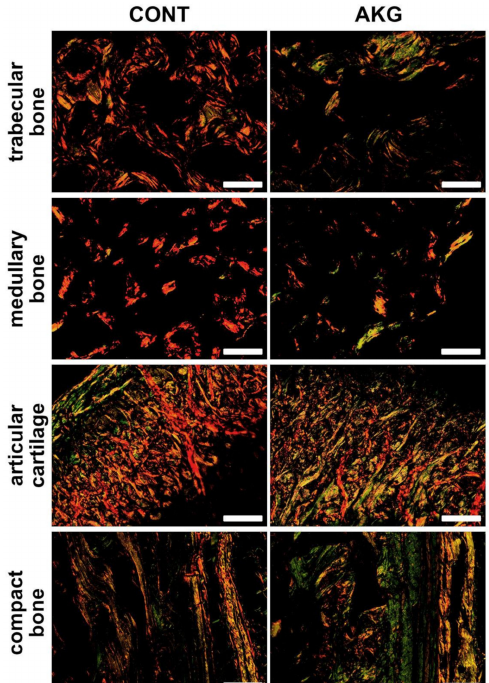
Figure 4. The influence of AKG supplementation during the experimental period (31–60 weeks of age) on bone collagen in laying hens at the age of 60 weeks. Representative images of PSR stained sections carried out on formaldehyde-fixed sections from the tibial articular cartilage and bone of laying hens from the control (CONT) and AKG supplemented (AKG) groups, observed in polarized light. The large mature collagen fibers are orange or red and the thick ones, including the reticular fibers, are green. All scale bars represent 100 µ m.